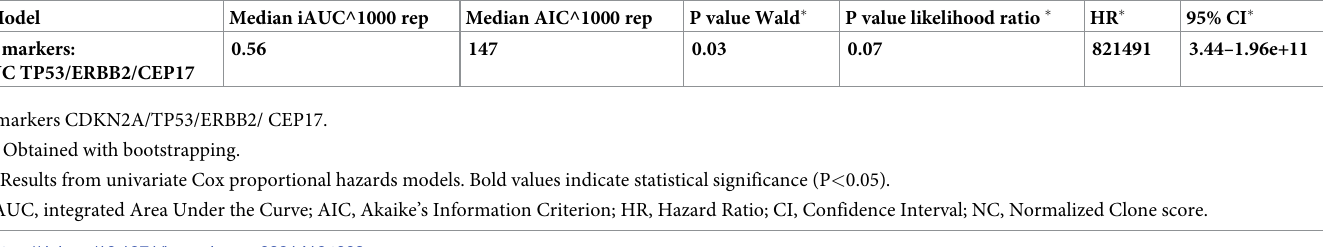
Table 2. Outcomes of the best performing clonal diversity score over set 1 † . Model